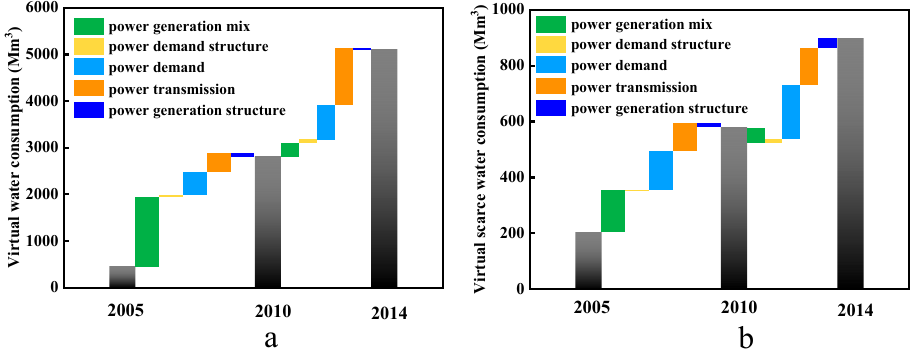
Figure 6. The contribution of different factors to the change of ( a ) virtual water transmission; ( b ) virtual scarce water transmission.